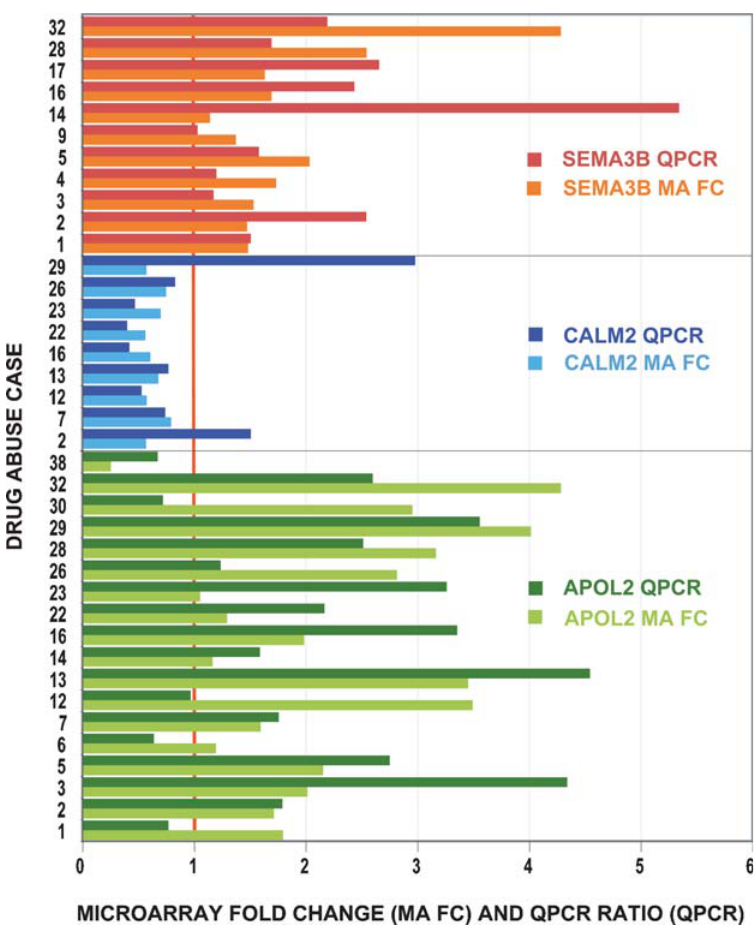
Figure 3. Validation of microarray data by quantitative PCR (QPCR) . Three representatives of consistently changed functional groups (Table 3) were examined by QPCR: calmodulin 2 (CALM2, blue bars), apolipoprotein 2 (APOL2, green bars), and semaphorin 3B (SEMA3B, orange bars). Numbers on the x-axis represents either the microarray-derived fold change (FC, lighter blue, green or orange bars) for each drug abuse case compared to the four best-matched control cases or the QPCR ratio (QPCR, darker blue, green or orange bars), while numbers on the y-axis represent the drug abuse case examined. QPCR validated 32/38 (84%) of the microarray data, which was performed using separate sets of brain dissections and RNA extractions from each drug abuse case and the four individual best-matched controls.